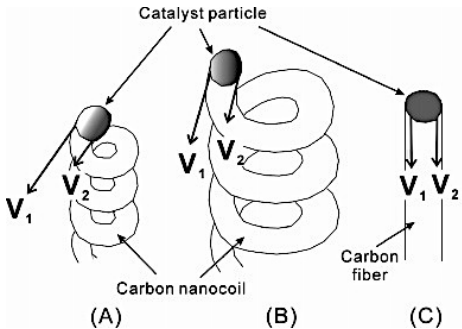
Figure 13. Schematic of carbon nanocoils and fiber grown from various Sn compositions.